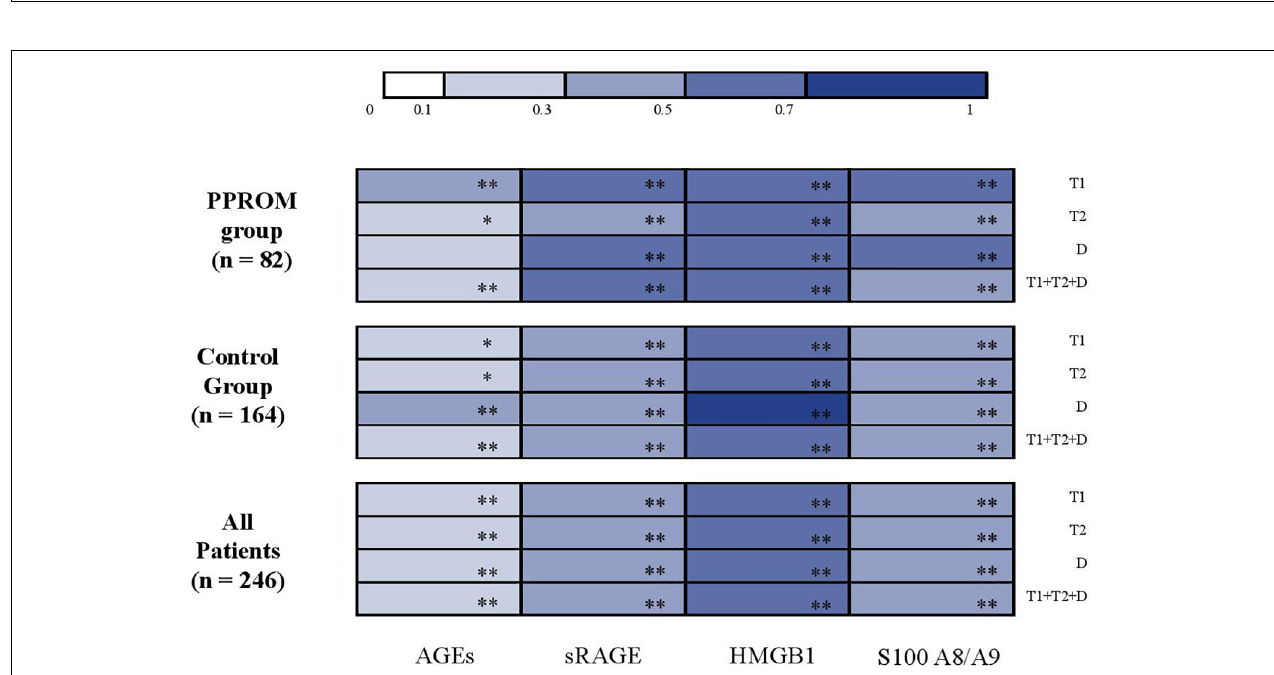
FIGURE 3 | Correlation analysis between AGEs, sRAGE, HMGB1, and S100A8/A9 concentrations in serum-extracted extracellular vesicles and in plasma (color-coded heat map plot). AGEs, advanced glycation end products; D, delivery; HMGB1, high-mobility group box 1; PPROM, preterm premature rupture of membranes; sRAGE, soluble receptor of advanced glycation end products; T1, first trimester; T2, second trimester. * p < 0.05; ** p < 0.001.